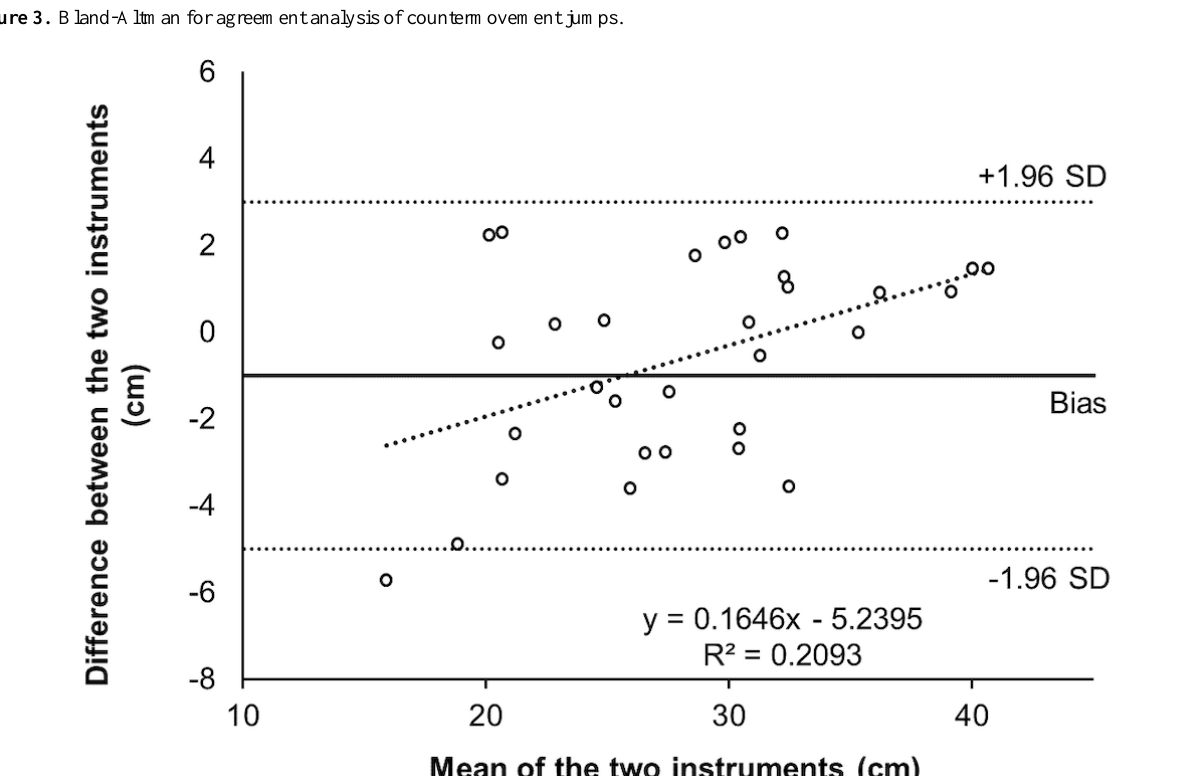
Figure 3. Bland-Altman for agreement analysis of countermovement